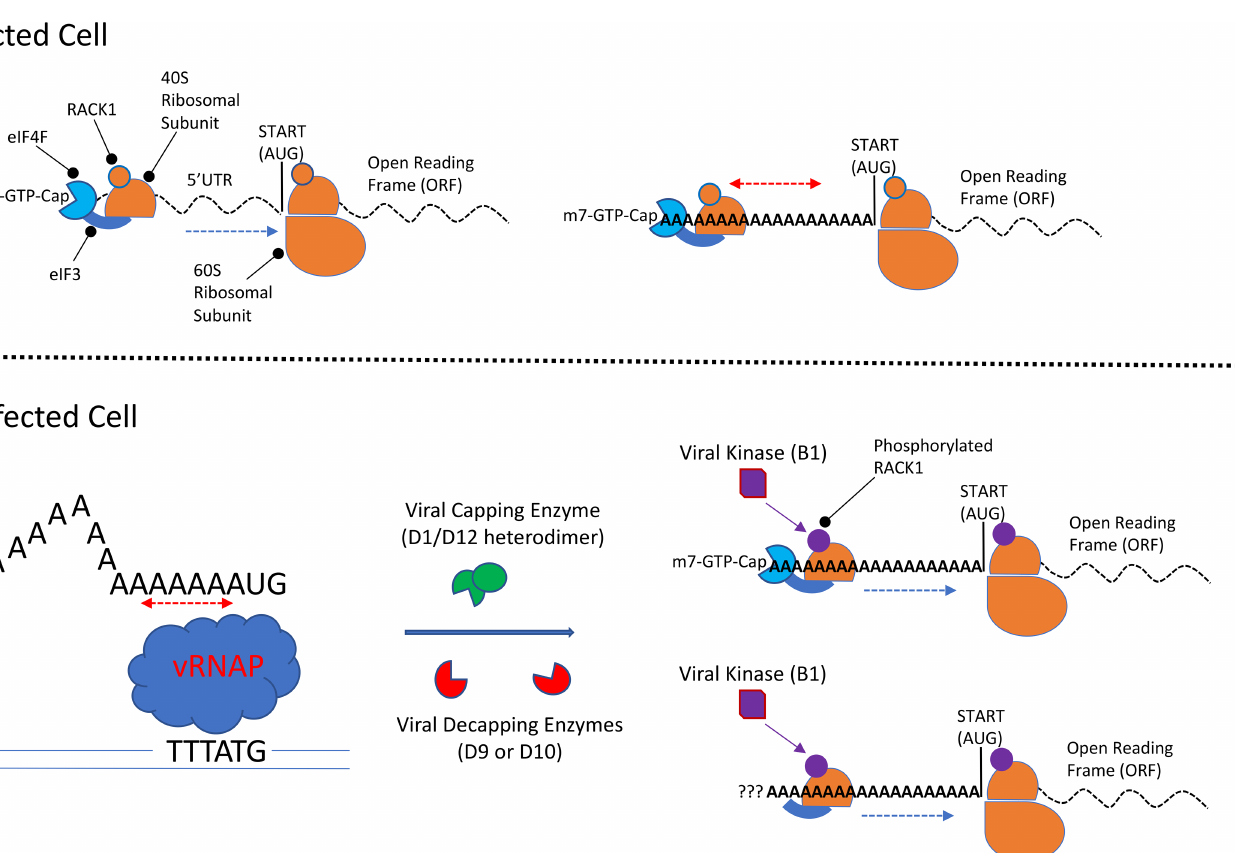
PLOS Pathogens| https://doi.org/10.1371/journal.ppat.1006634 November 16,